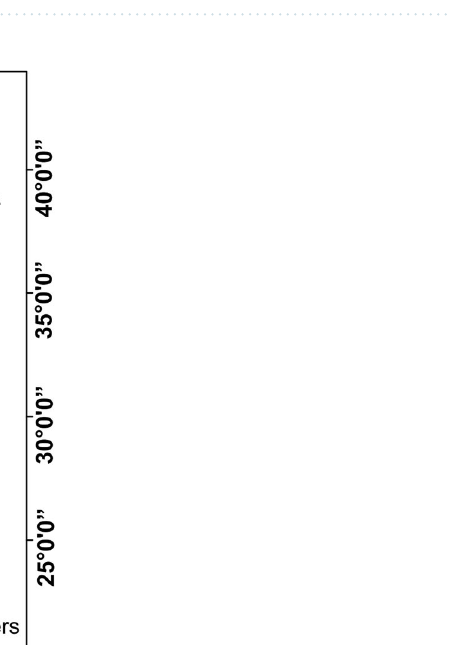
Figure 4. Demographic history of T. g. zarudnyi and T. g. buxtoni (subclade C) represented by mismatch distribution analyses; observed (dashed line) and expected (solid line).